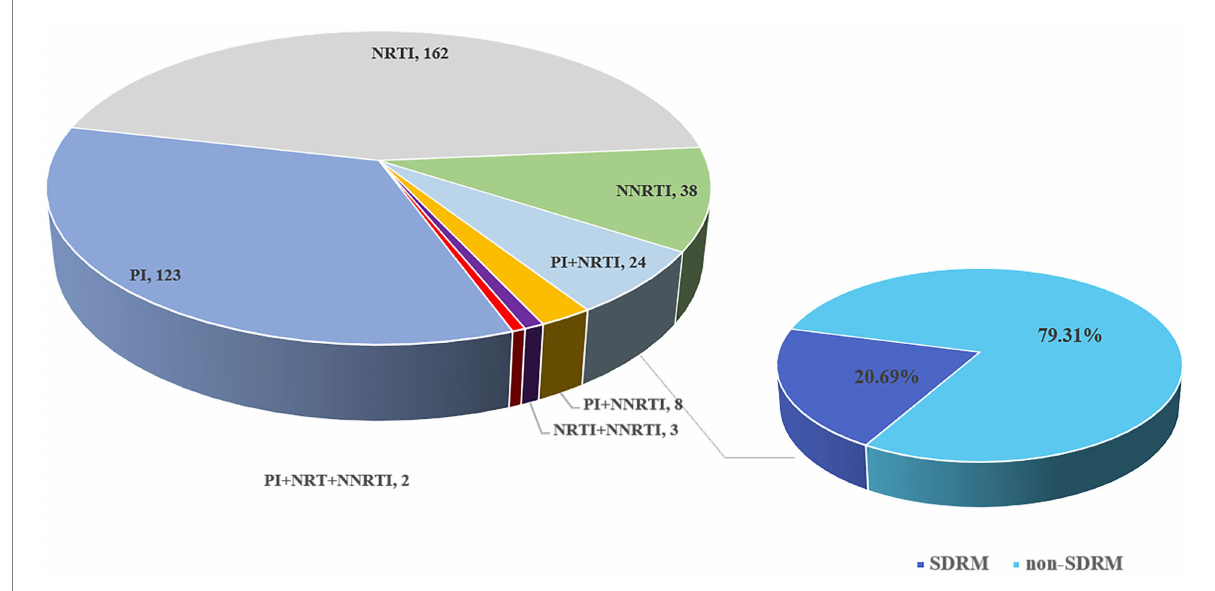
FIGURE 8 Composition and distribution of SDRM in newly diagnosed HIV-1 samples in Shenzhen from 2014 to